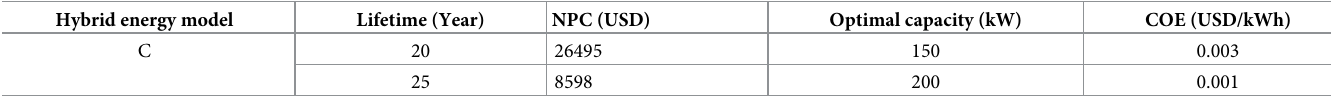
Table 9. PV lifecycle-based sensitivity analysis. Hybrid energy